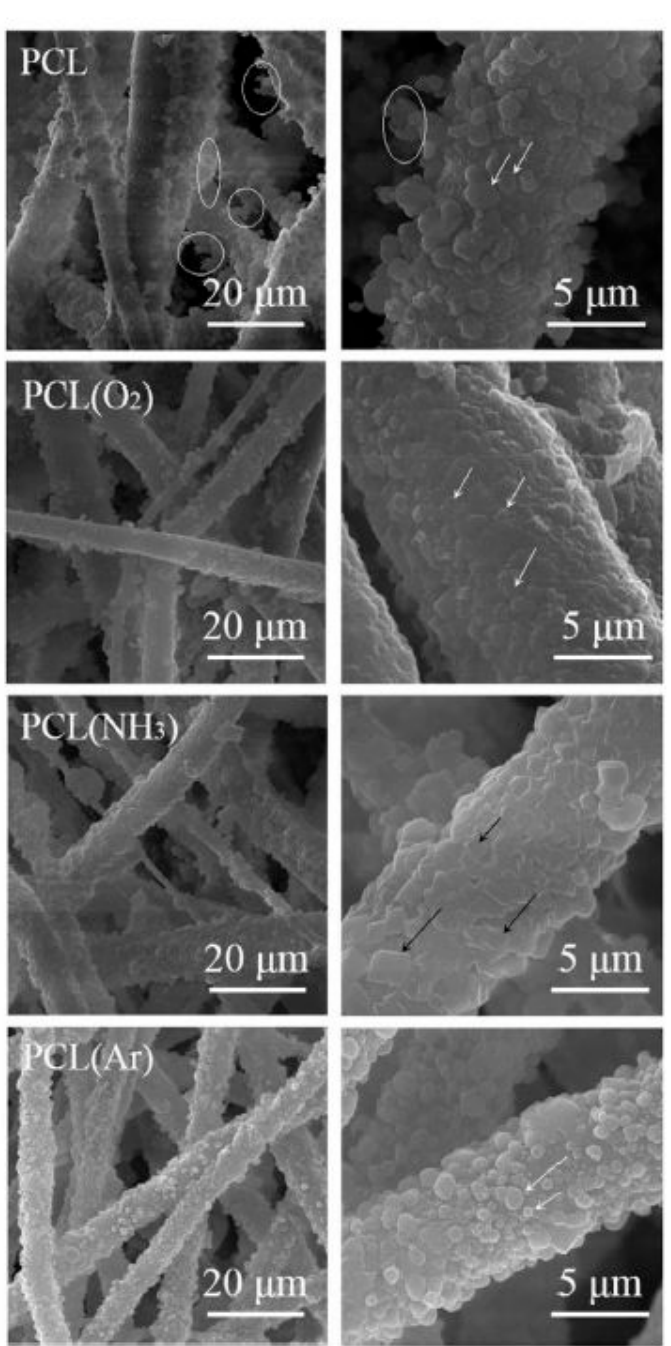
Figure 23. SEM images of CaCO 3 enrichment on untreated, O 2 , NH 3 , and Ar plasma-treated PCL nanofibrous scaffolds at different magnifications—reproduced with permission from [244].